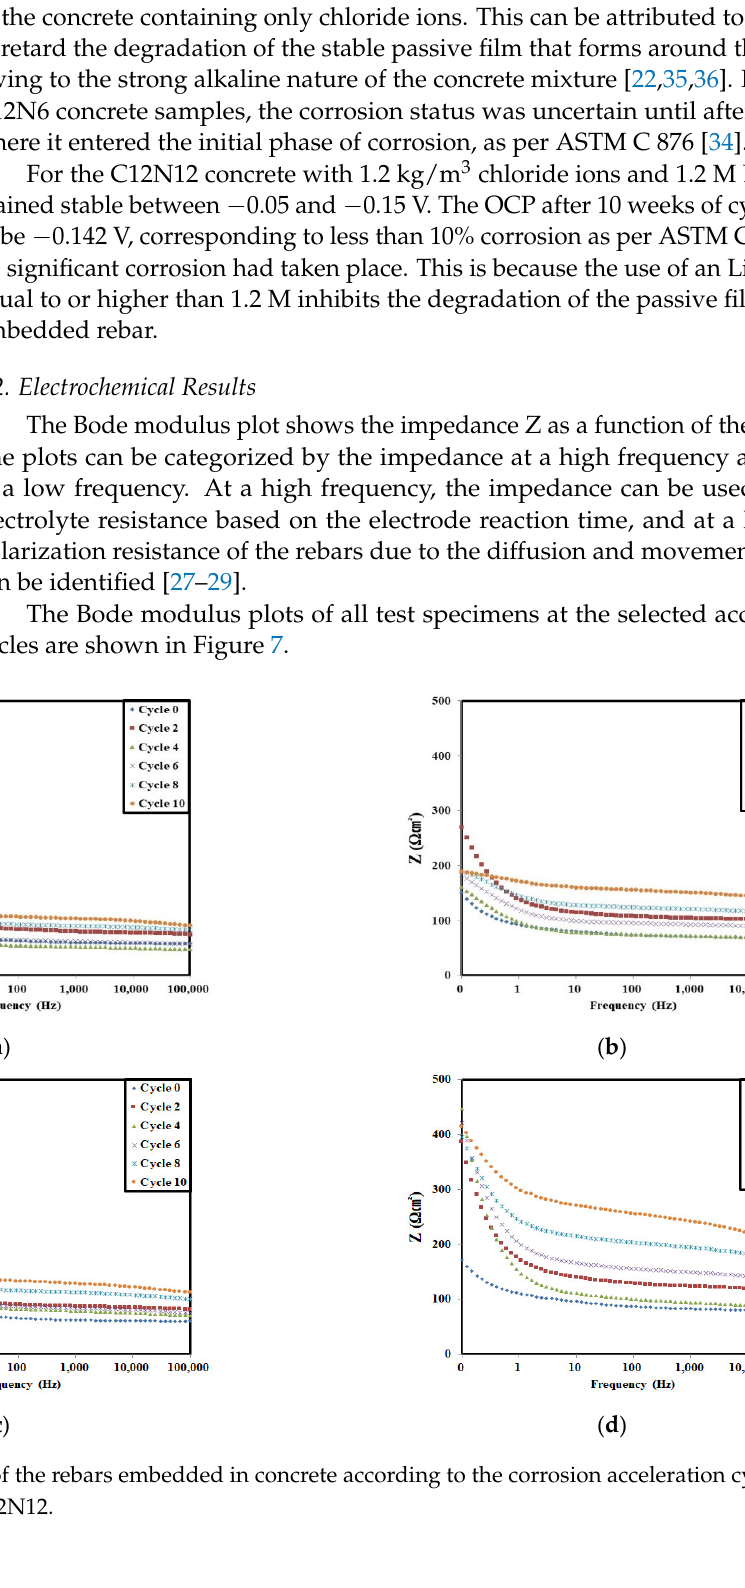
Table 6. Variation in R p with accelerated corrosion cycle.